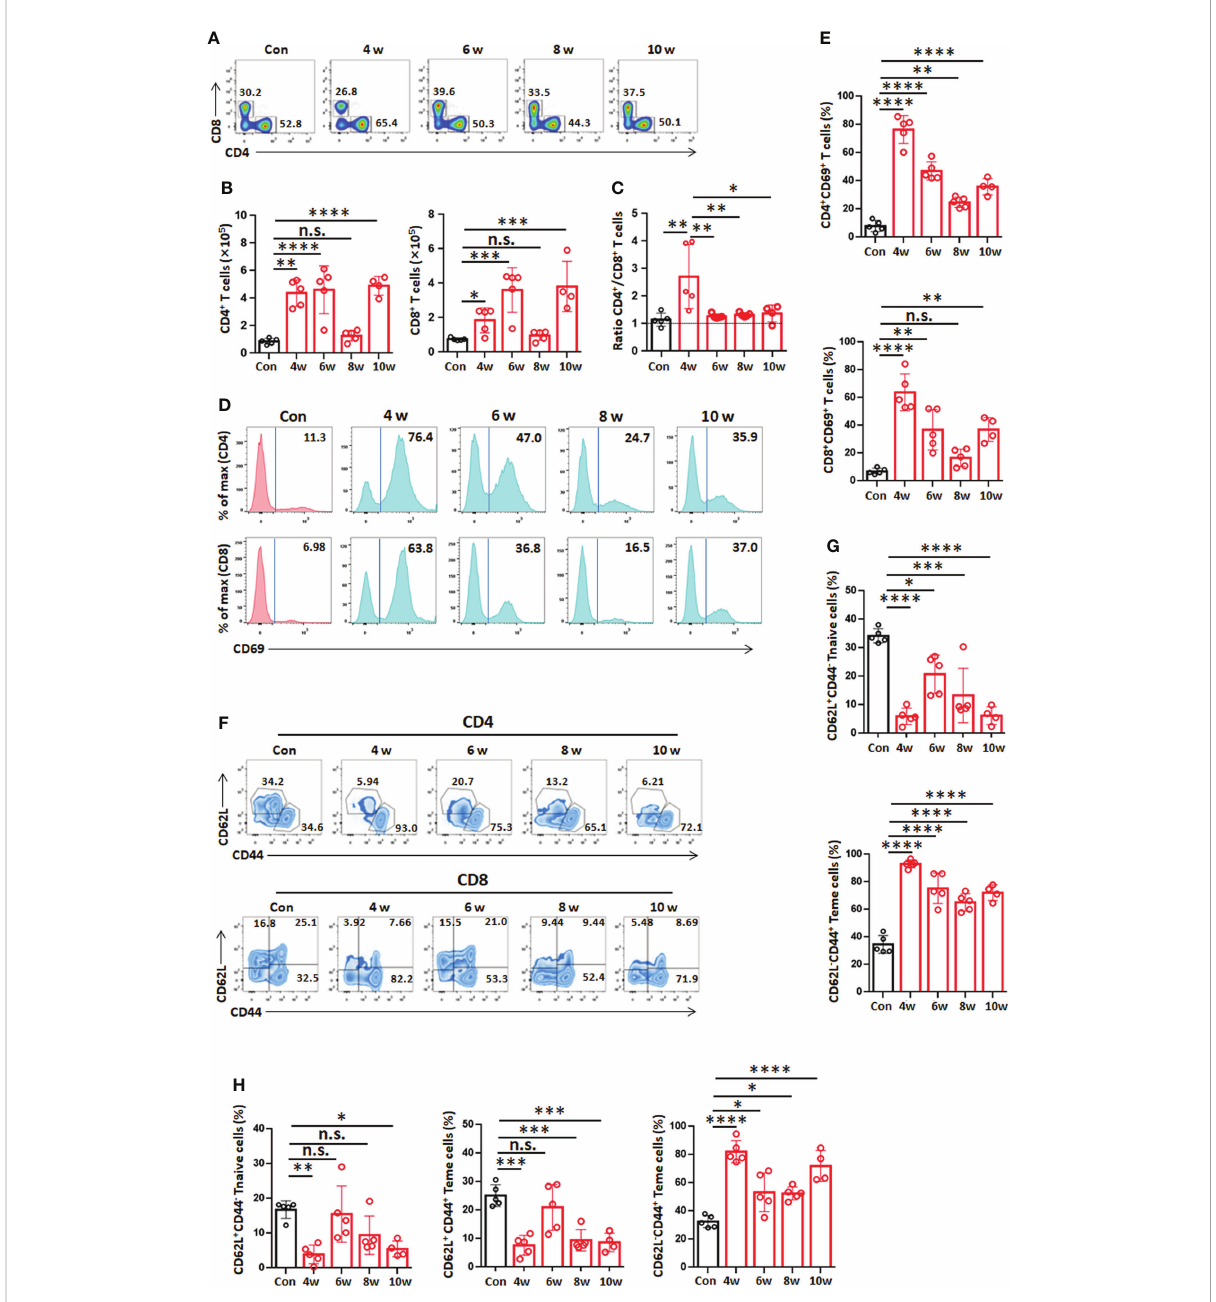
FIGURE 4 T-cell phenotypes in the liver in the mouse model during Egranulosus s.s. establishment. (A) Representative fl ow cytometric analysis for hepatic CD4 + T cells or CD8 + T cells from mouse model during Egranulosus s.s. establishment. (B) Absolute quanti fi cation of hepatic CD4 + T cells or CD8 + T cells from mouse model during Egranulosus s.s. establishment. (C) The ratio of CD4 + T cells to CD8 + T cells in the liver. (D) Representative fl ow cytometric analysis for hepatic CD4 + T cells or CD8 + T cells expressing CD69 from mouse model during Egranulosus s.s. establishment. (E) The percentage of hepatic CD4 + T cells or CD8 + T cells expressing CD69, from (D) . (F) Representative fl ow cytometric analysis for CD44 and CD62L expression in hepatic CD4 + T cells or CD8 + T cells from mouse model during Egranulosus s.s. establishment. (G) The percentages of CD4 + naïve T cells (Tn, CD44 - CD62L + ) and CD4 + effector memory T cells (Tem, CD44 + CD62L - ) on CD4 + T cells in the liver, from (F) . (H) The percentages of CD8 + naïve T cells (Tn, CD44 - CD62L + ), CD8 + central memory T cells (Tcm, CD44 + CD62L + ) and CD8 + effector memory T cells (Tem, CD44 + CD62L - ) in the liver, from (F) . 4-5 mice per group. Data are expressed as mean ± SD, analyzed by one way ANOVA. * P < 0.05, ** P < 0.01, *** P < 0.001, **** P < 0.0001, no signi fi cance(n.s.) P >